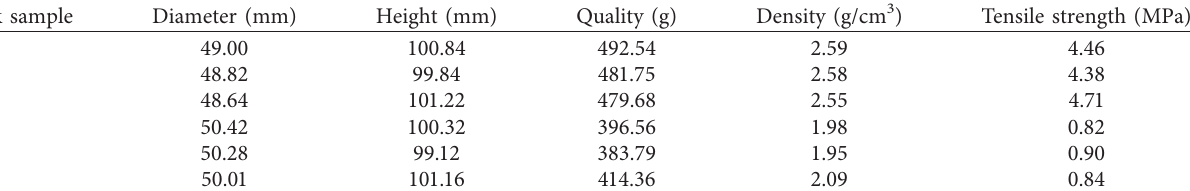
Table 1: Physical parameters of rock samples.